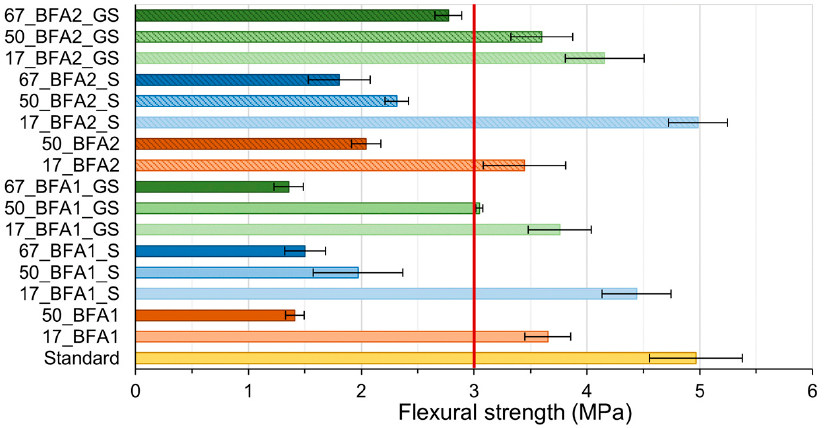
Figure 8. Flexural strength of the mortars cured for 28 days, compositions prepared with BFA1 and BFA2. The red line represents the minimum values required for the target application.